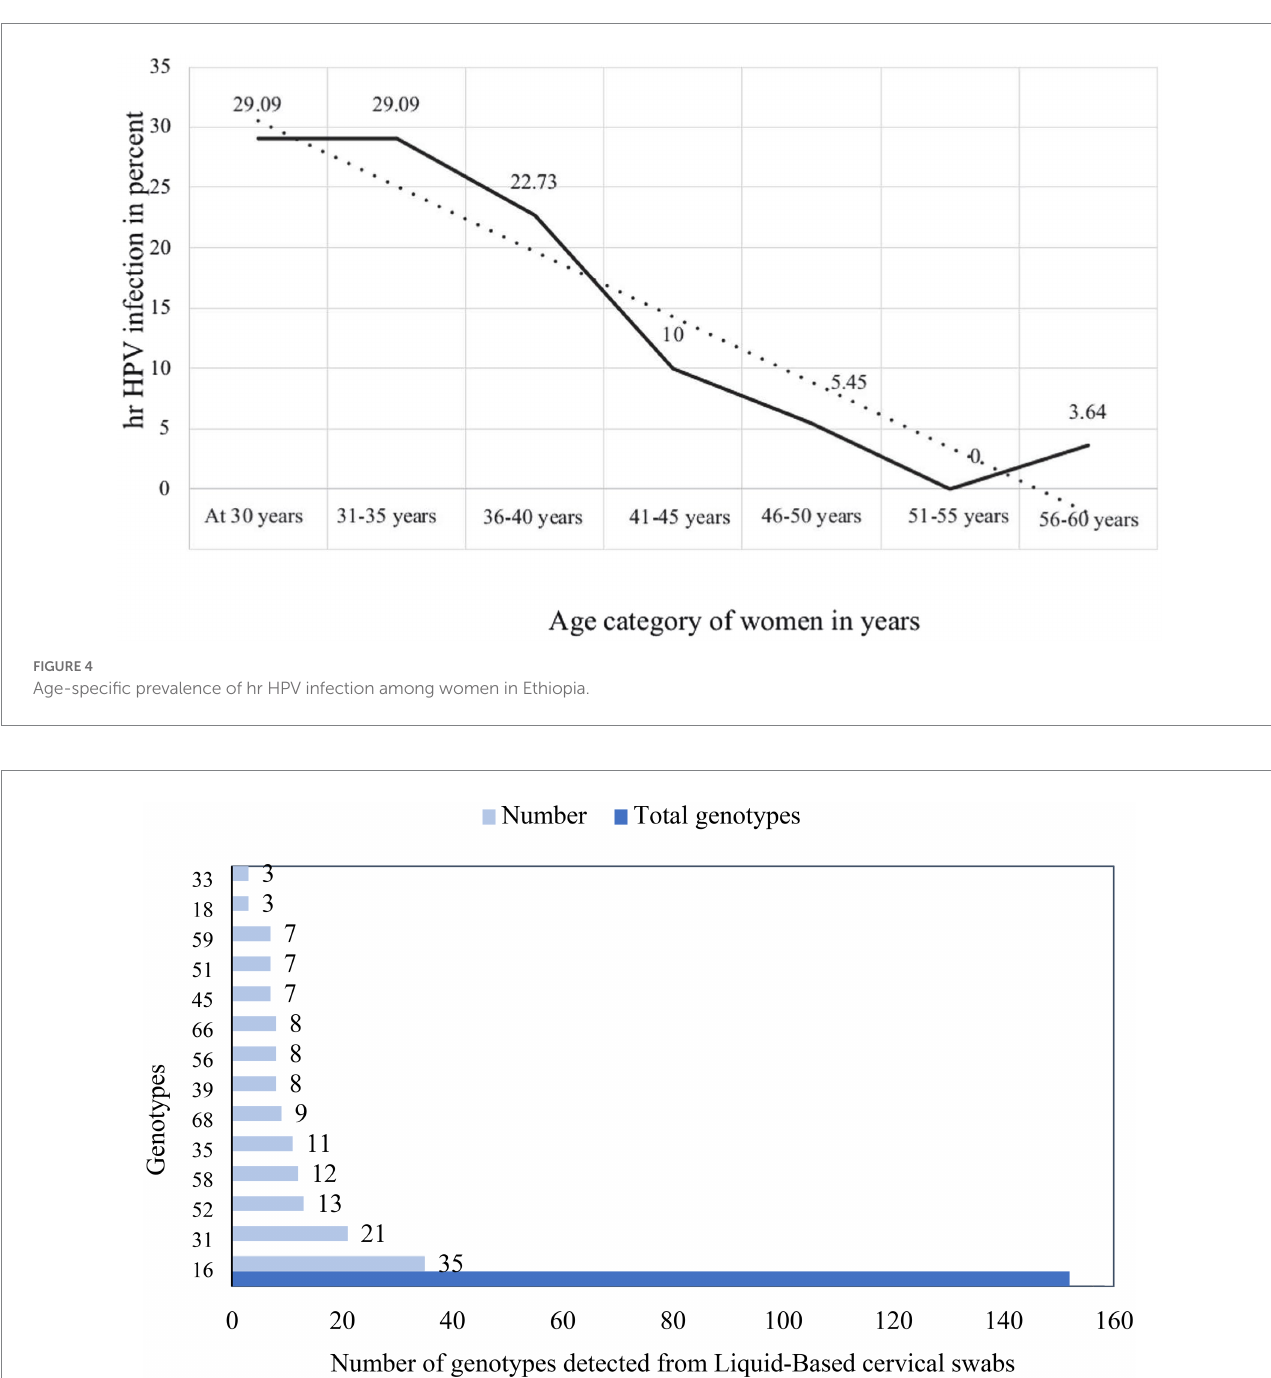
FIGURE 5 Genotypes and frequency of hr HPV among women in